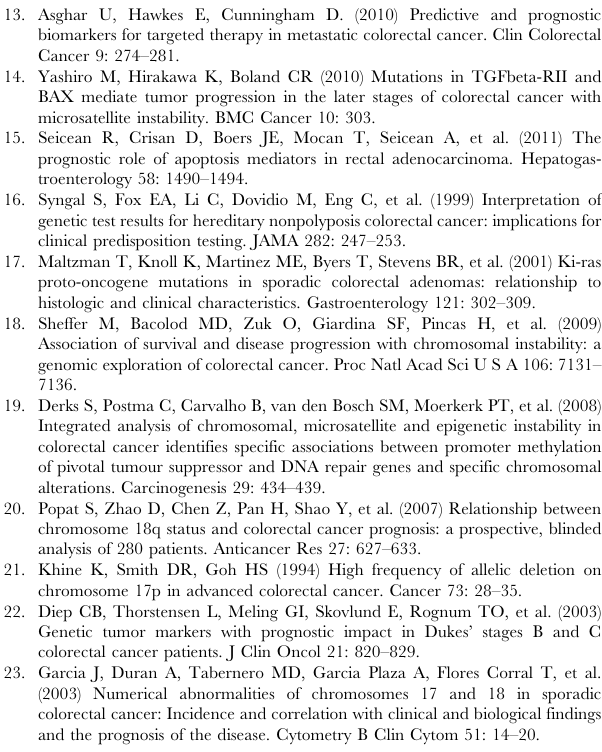
Figure S1 Validation of the impact of chromosome 17 status on overall survival in an independent series of sCRC patients from the GEO database (n =109): panel A, del(17p13); panels B and C, del(17p) harbouring pericentromeric breakpoints at chromosome 17p and del(17p) harboring a pericentromeric breakpoint at both chromosomes 17p and 17q,